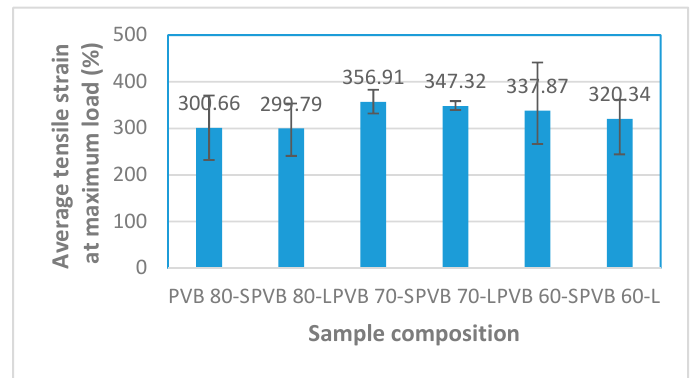
Figure 6. Average tensile strain at maximum load of the composite samples .